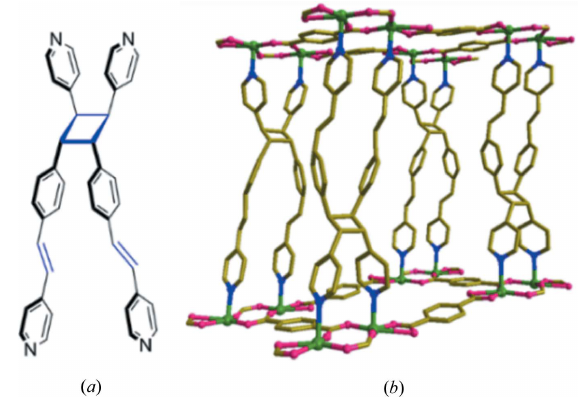
Figure 5 ( a ) The structural diagram of the monocyclized bpeb pairs in ( 6 ). ( b ) A portion of the structure of ( 6 ) showing the monocyclized bpeb pairs as the pillar in the photoproduct of ( 3 ). For clarity, the disorder and hydrogen atoms are not